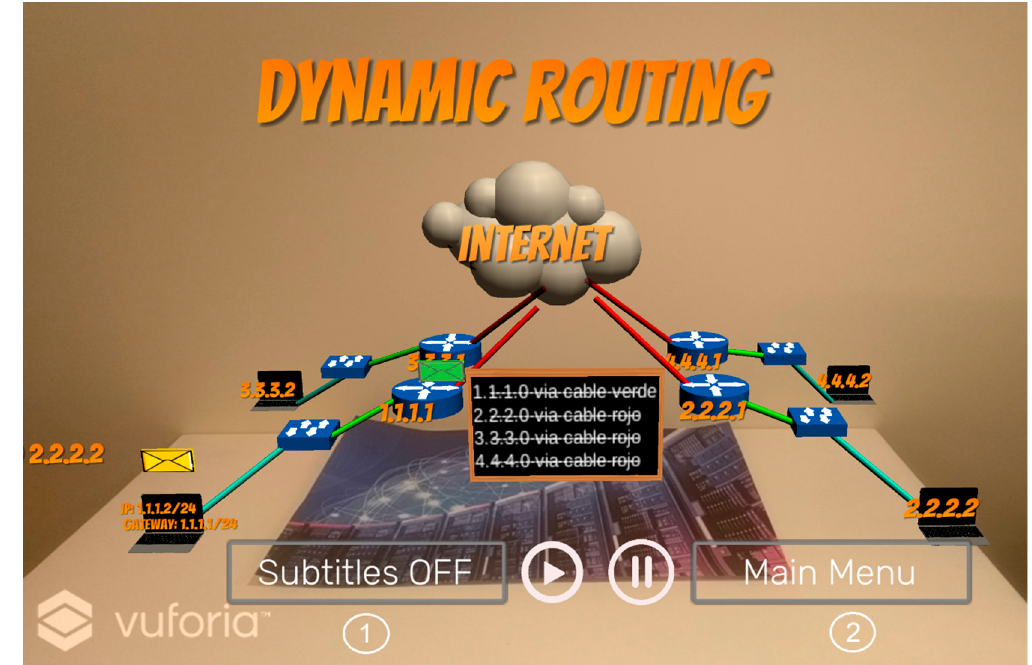
Figure 3. Level 2. Static IP addressing shown in NetAR. The application has the option to turn subtitles on and off for the explanation of the model shown ( 1 ); the user can start and pause the animation with the buttons placed on the screen. There is also an option to return to the main menu and access the other levels of NetAR ( 2 ).